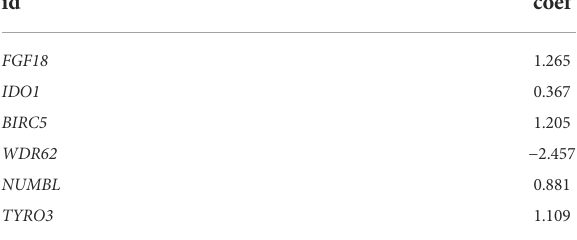
TABLE 1 The coef of the IRGPI in the multivariate Cox regression